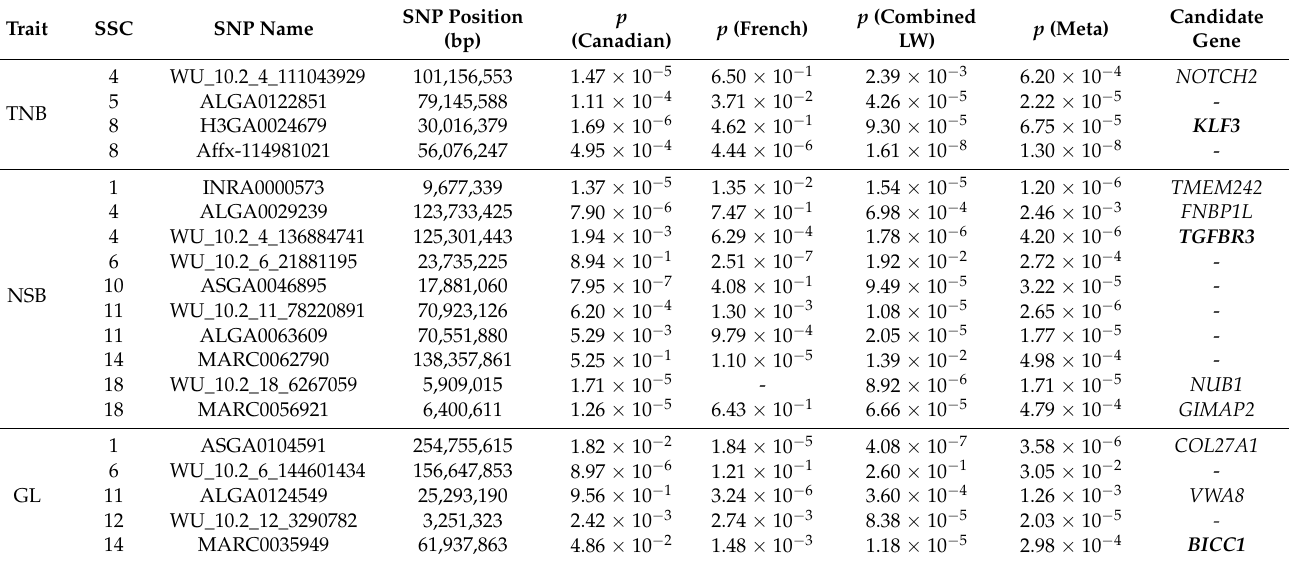
SSC, Sus scrofa chromosome. SNP name, name of significant and suggestive SNPs; SNP position (bp), the position of significant and suggestive SNPs. p (Canadian), p -value from within-population GWAS in the Canadian line. p (French), p -value from within-population GWAS in the French line. p (Combined LW), p -value from within-population GWAS in the combined two lines of Large White pigs. p (Meta), p -value from cross-population meta-analyses. Bolded text shows the potential candi- date gene detected in both chip and WGS data. For the NSB trait, the Manhattan plots are shown in Figure 3a–d. The Q-Q plots are shown in Supplementary Figure S3a–d, with genome inflation factors between 0.957 and